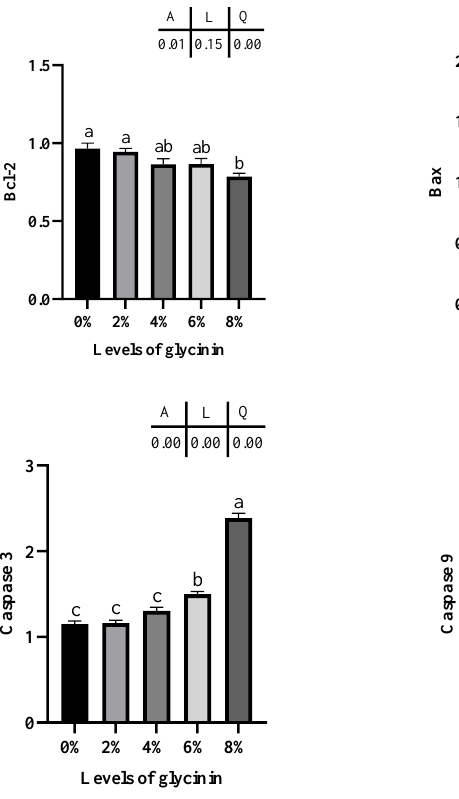
Figure 7. Expressions of apoptosis associated genes in posterior intestine of hybrid yellow catfish fed with different glycinin levels. Relative mRNA expression was evaluated by RT-qPCR. Data describe mean ± SE (n = 3). Obvious difference of means between groups is indicated by a, b and c ( p < 0.05). A represent the variance analyzed by one-way ANOVA; L represent linear trend analyzed by orthogonal polynomial contrasts; Q represent quadratic trend analyzed by orthogonal polynomial contrasts.